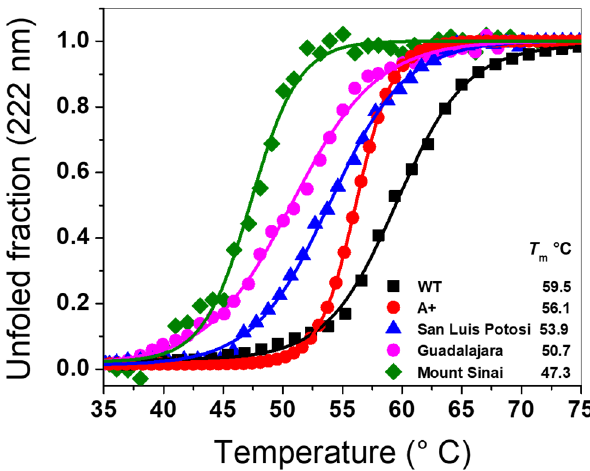
Figure 8. Analysis of structural stability of recombinant variants of G6PD. Thermal stability of the variants was followed by changes in DC signal at 222 nm through a temperature gradient (35–70 °C). Data were adjusted to Boltzman’s sigmoid equation in Origin 8.0 to obtain T m value. The experiment was conducted in